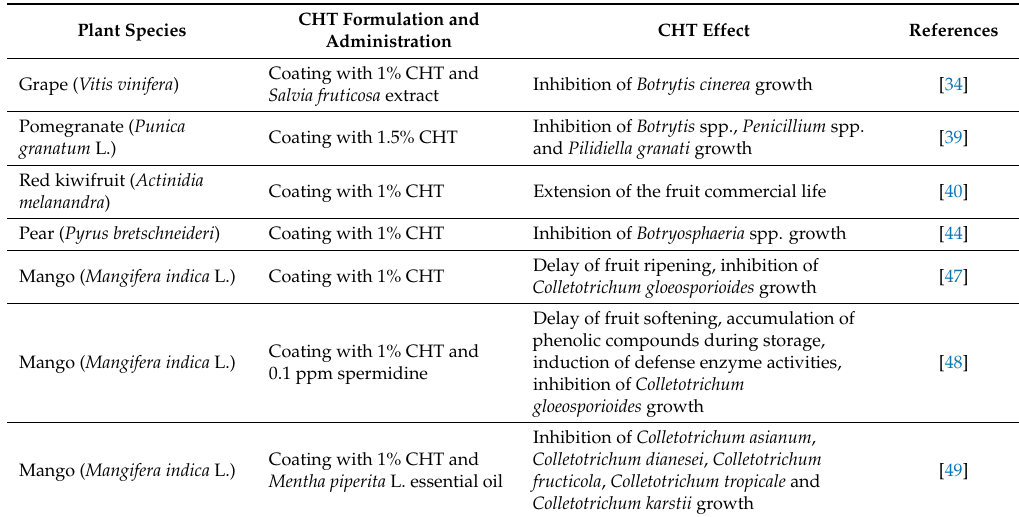
Table 3. CHT effects on